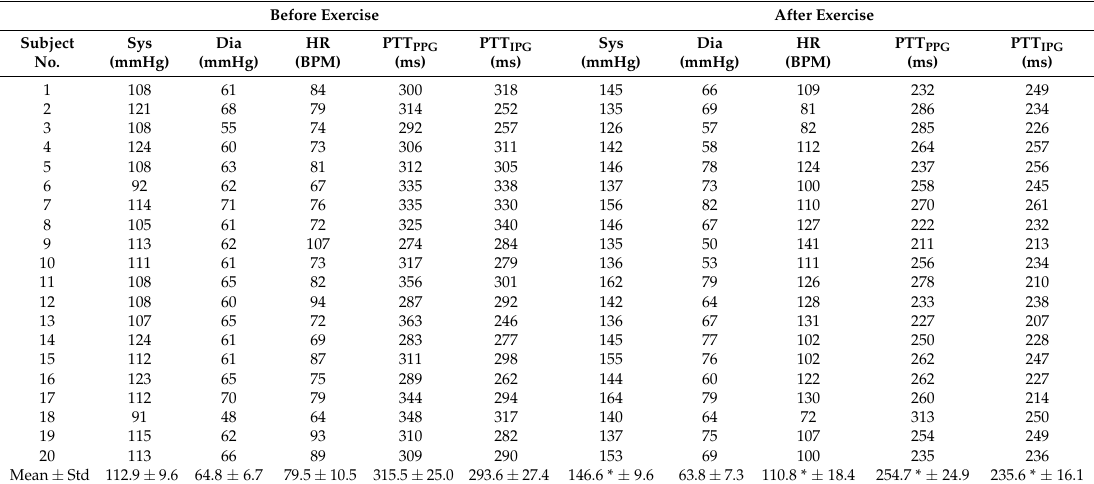
Table 2. In the first test, the measurement parameters before and after exercise. Before Exercise After